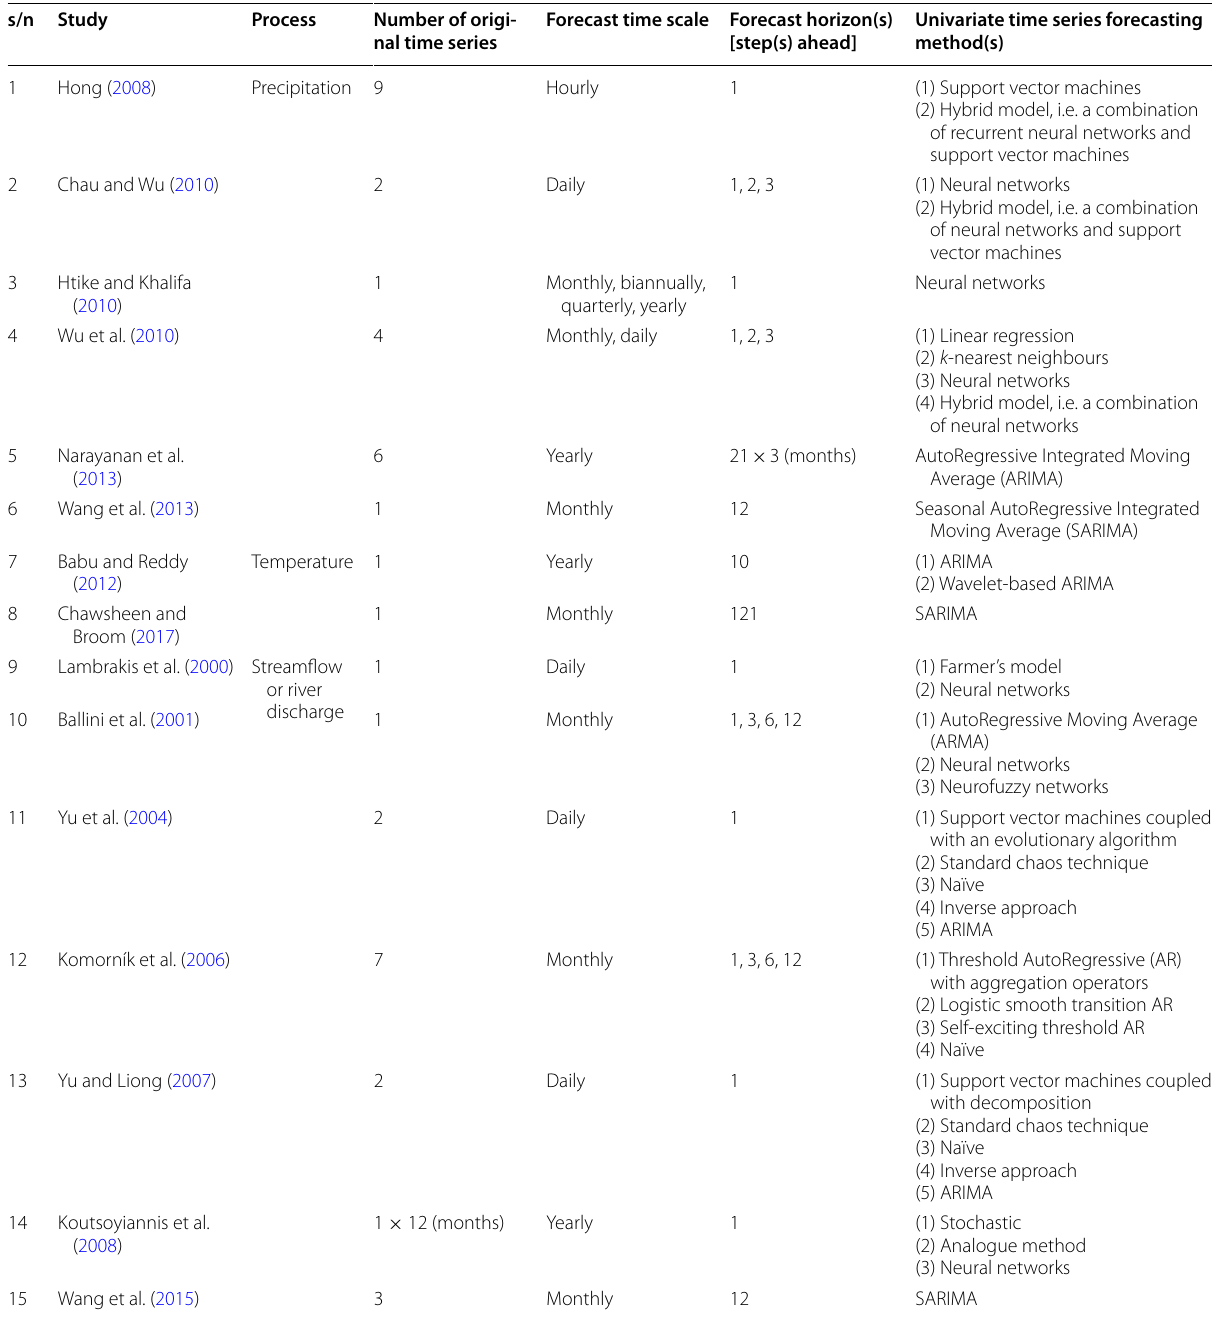
Table 1 Examples of univariate time series forecasting in